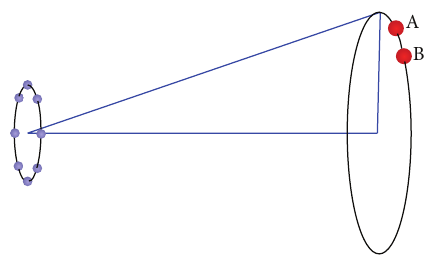
Figure 9: Sketch of OAM generation and